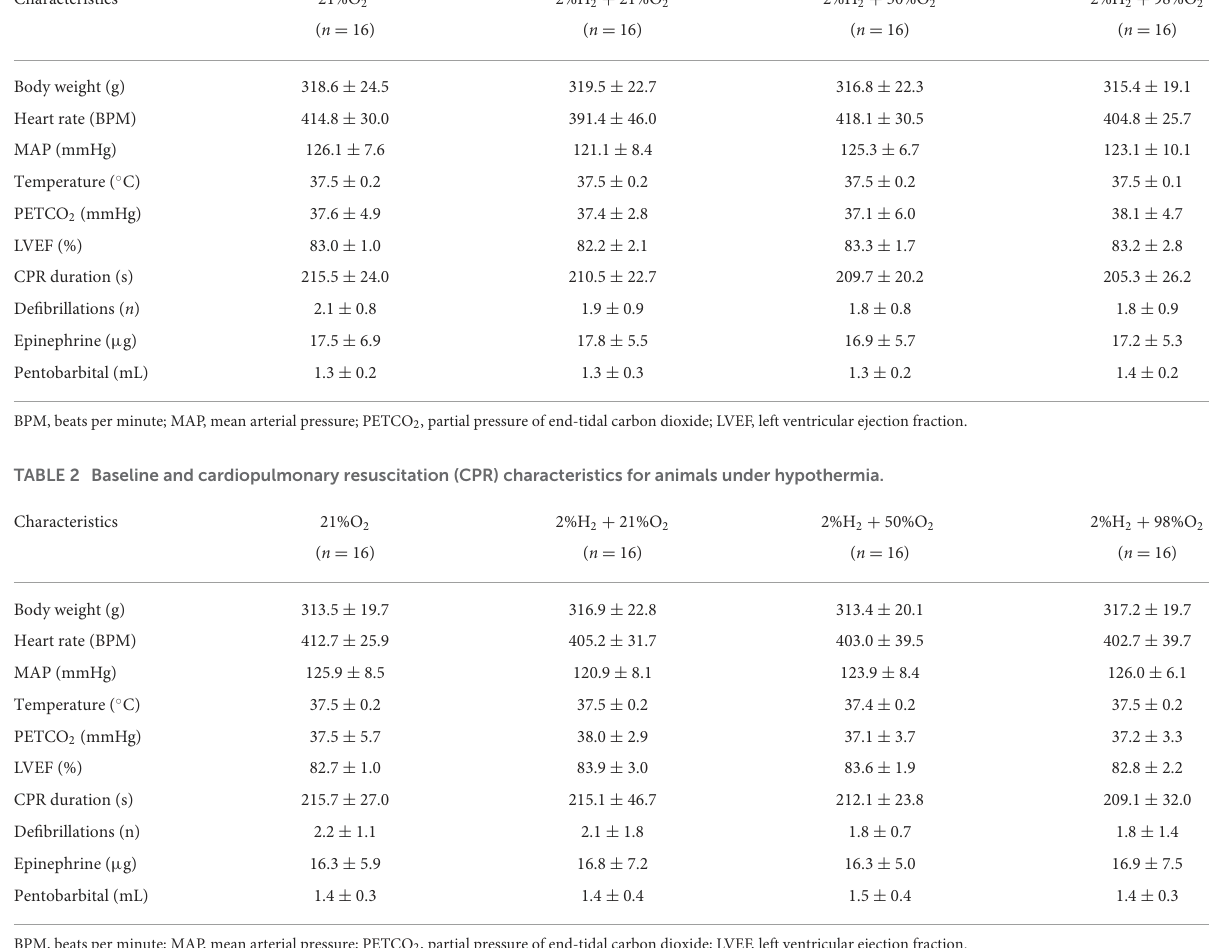
TABLE 1 Baseline and cardiopulmonary resuscitation (CPR) characteristics for animals under normothermia. Characteristics